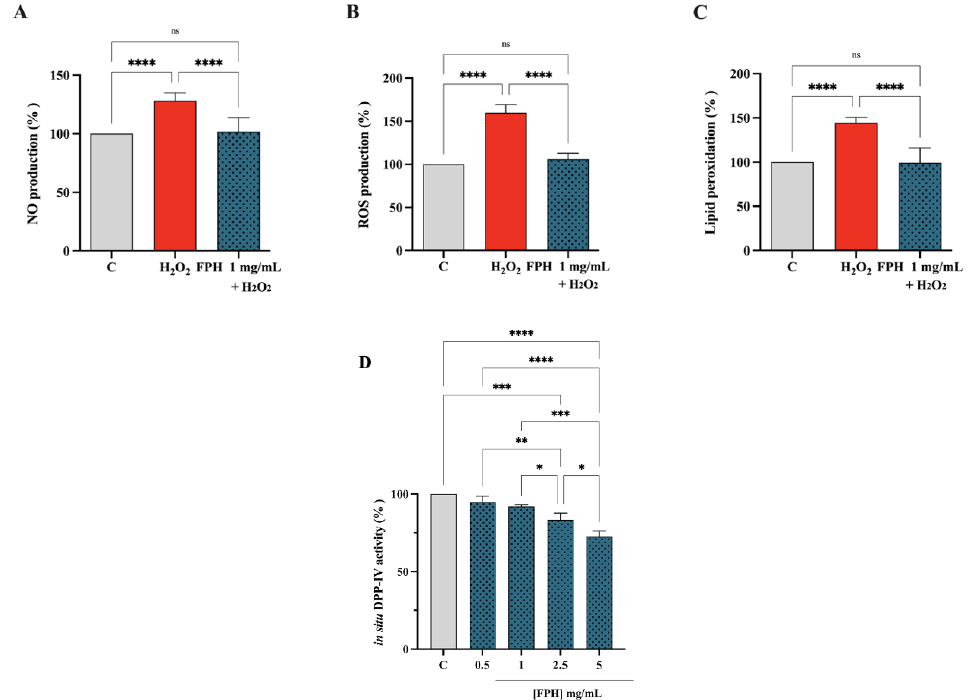
Figure 4. Effect of FPH on the H 2 O 2 -induced NO production in human intestinal cells ( A ). Modulation of intracellular ROS level H 2 O 2 -induced after the pretreatment with FPH ( B ). Modulation of lipid peroxidation H 2 O 2 -induced after the pretreatment with FPH ( C ). In situ inhibition of the DPP- IV activity expressed by nondifferentiated Caco-2 cells, after 3 h of treatment ( D ). The data are represented as the means ± SD of six independent experiments, performed in triplicate. Statistical analysis was performed by one- way ANOVA, followed by Tukey’s post -hoc test. ns: not significant; (*)